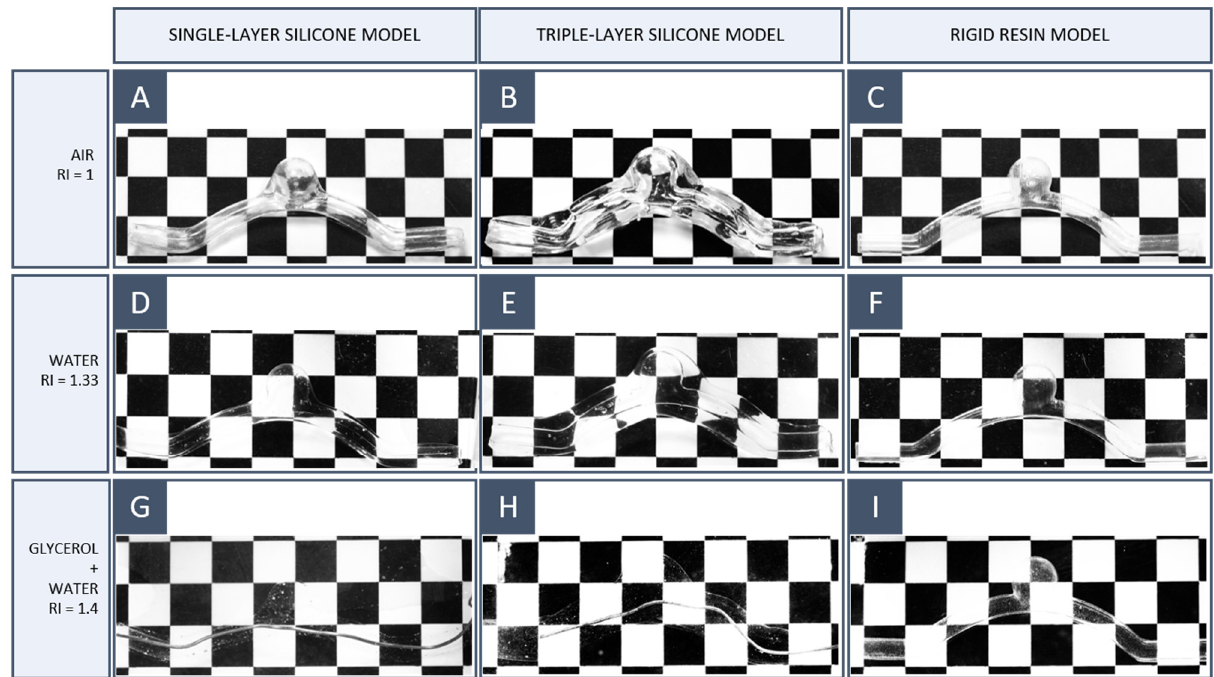
Figure 11. Index of refraction matching test for 3D printing model: ( A , B , C ) air, ( D , E , F ) water, and ( G , H , I ) 50/50 glycerol/water solution. The first column corresponds to the single silicone layer model (S1); the second corresponds to the triple silicone layer model (S2) and the third corresponds to the rigid SLA resin model (S3).